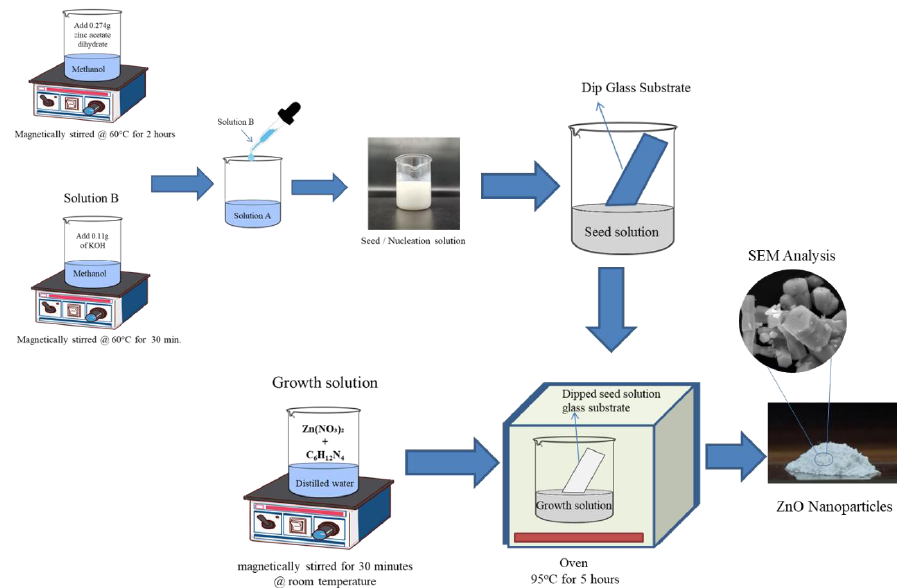
Figure 1. Schematic diagram of the production of ZnO nanoparticles .